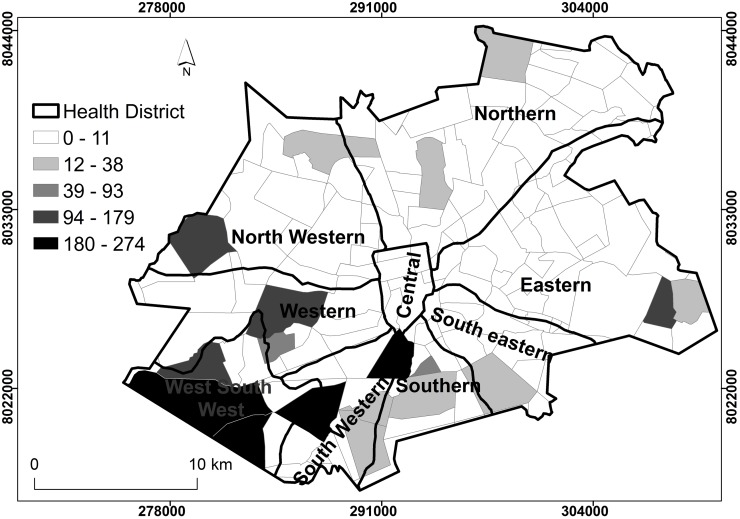
Spatial distribution of TB prevalence rates by district, Harare City, 2011.Show the spatial distribution of TB prevalence rates by district. Clear suburbs and districts show that TB cases were not related to neighbouring districts. Shaded districts showed relatedness. The intensity of the shade reflected the number of TB cases per district related to neighbouring districts.